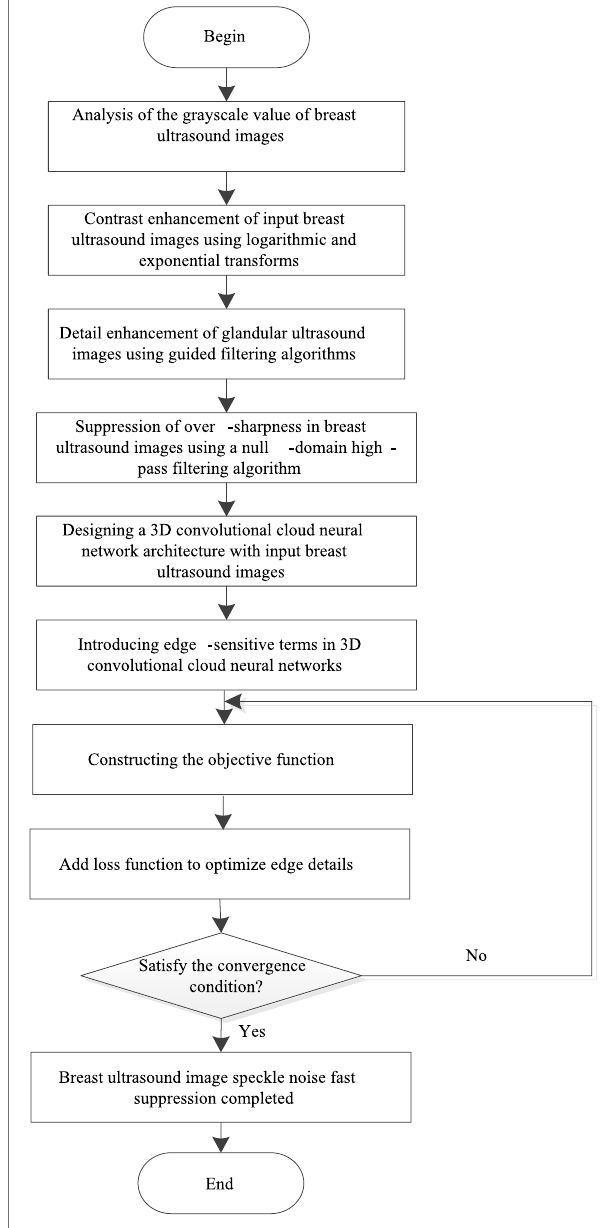
FIGURE 3 | Fast speckle noise suppression algorithm process in breast ultrasound